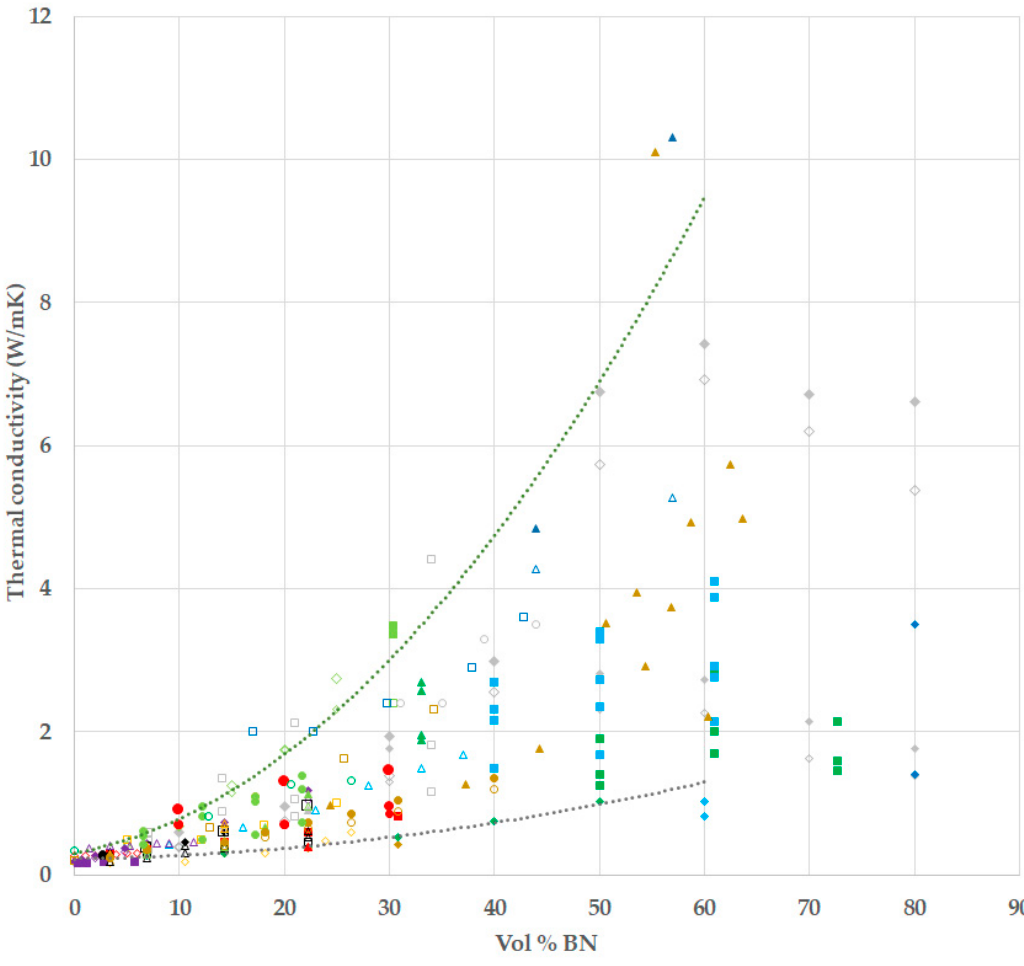
Figure 1. Dependence of thermal conductivity of epoxy-boron nitride (BN) composites on vol % of BN. Data taken from the literature, with the BN particles size(s) or range given in microns, larger symbols for larger particles. Diamonds: grey [5] 3.6; black [6] 0.07, 5; red [7] 0.06; orange [8] 0.4; brown [9] 0.5; light green [10] 13, 25; dark green [11] 0.9; light blue [12] 1, 5; dark blue [13] 6, 18; purple [14] 3–5. Squares: grey [15] 10; black [16] <1, 5–10; red [17] 2; orange [18] 2; brown [19] 6; light green [20] 5–10; dark green [21]; light blue [22] 1–12; dark blue [23] 50; purple [24] 0.004–0.040. Triangles: grey [25] 4–8; black [26] 1; red [27]; orange [28] 1, 5; brown [29] 3–5; light green [30]; dark green [31] 30; light blue [32] 30; dark blue [33] 5–11; purple [34] 100. Circles: grey [35] 10–30; black [36] 3; red [37] 0.053, 0.15, 4; orange [38] 0.07, 7; brown [39] 0.5; light green [40] 0.07, 7; dark green [41] 7–15. Filled symbols represent composites made with BN particles surface treated and/or with coupling agent; open symbols for untreated particles and without coupling agent. Data points in colour can be seen in the on-line version of this paper. Dotted lines are upper and lower trend curves, drawn to guide the